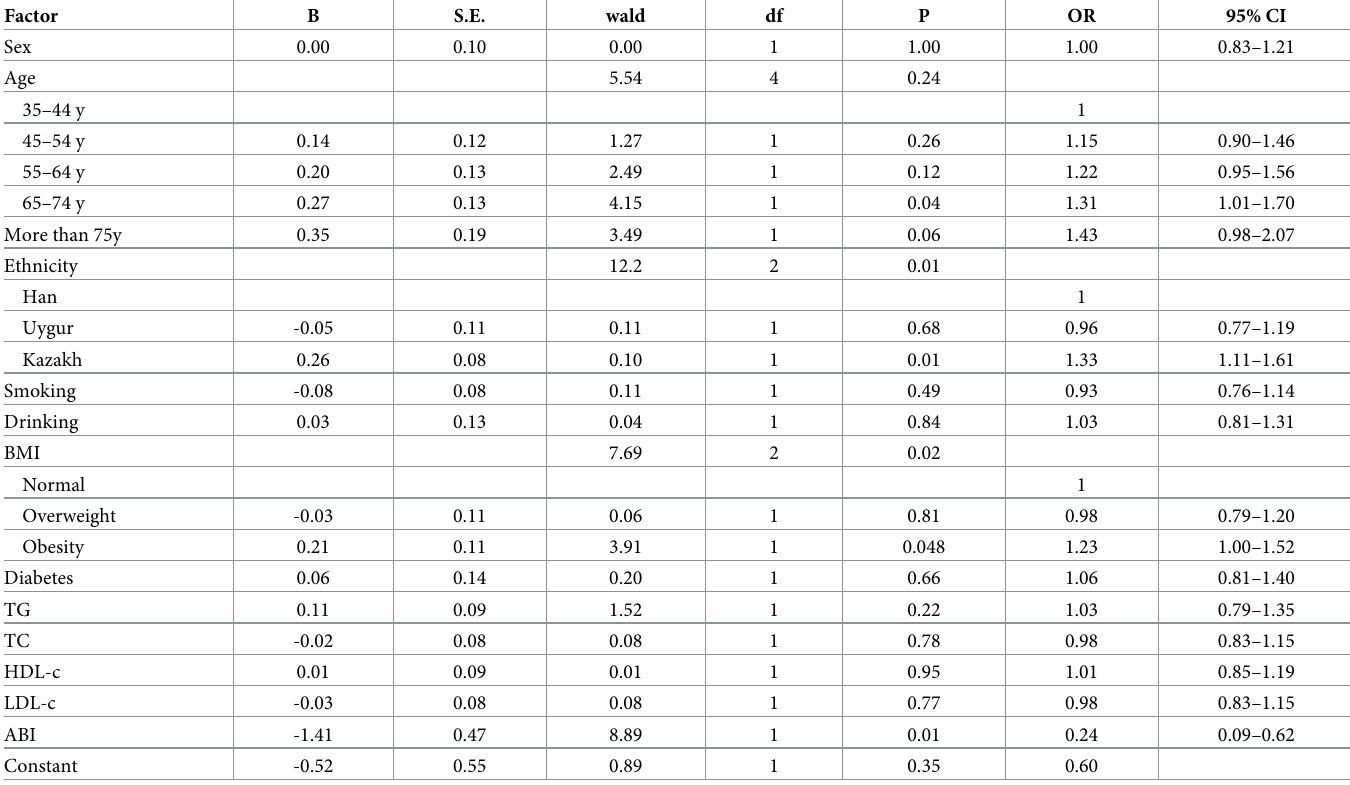
Table 6. Multivariate unconditional logistic regression analysis of risk factors for IAD in the hypertensive population. Factor